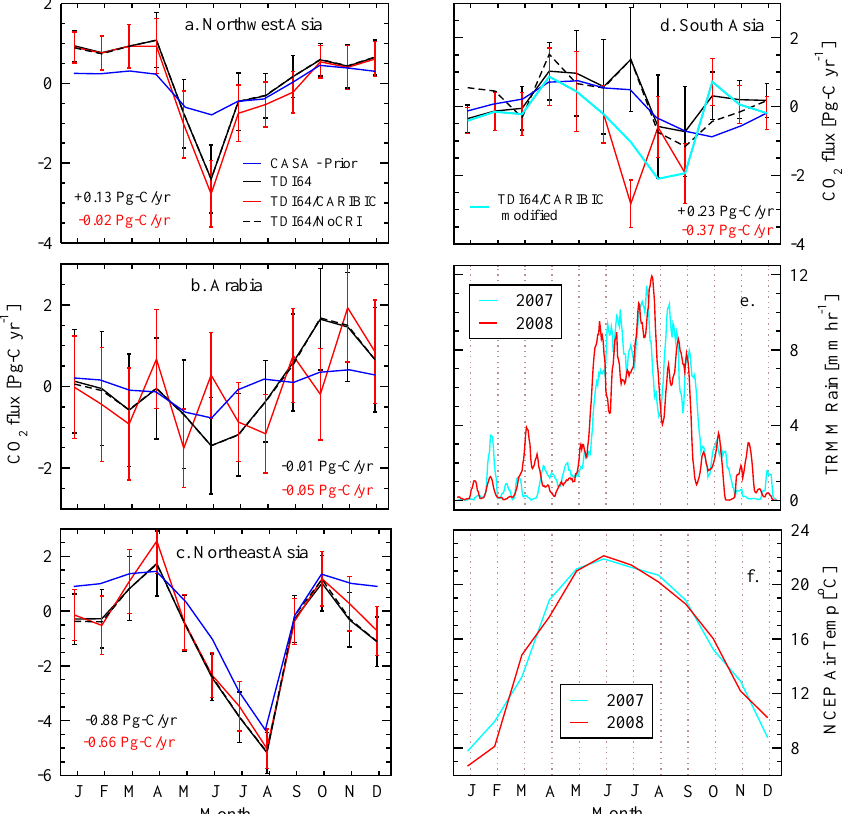
Fig. 3. Comparisons of CO 2 flux seasonal cycles of 4 Asian regions in 64-region inversion (a–d) for 2008. The numbers within each panel are annual total CO 2 fluxes ( > 0 for sources or net release by the land biosphere; < 0 for sinks or net uptake) only for TDI64 and TDI64/CARIBIC inversion cases. A sensitivity inversion run without including the Cape Rama, India site (TDI64/NoCRI) is also shown for comparison. This figure reveals maximum impact of CARIBIC data on South Asian flux prediction by 64-region inverse model, in particular during the JAS months (ref. Fig. 2 for global distribution). We also show (e) Tropical Rainfall Measuring Mission (TRMM) daily rainfall data at daily time intervals (Iguchi et al., 2000; data source: http://mirador.gsfc.nasa.gov), and (f) the air temperature at 2m from the National Center for Environmental Prediction (NCEP) reanalysis (source: www.cdc.noaa.gov) for 2007 and 2008. Tickmarks are shown at middle of